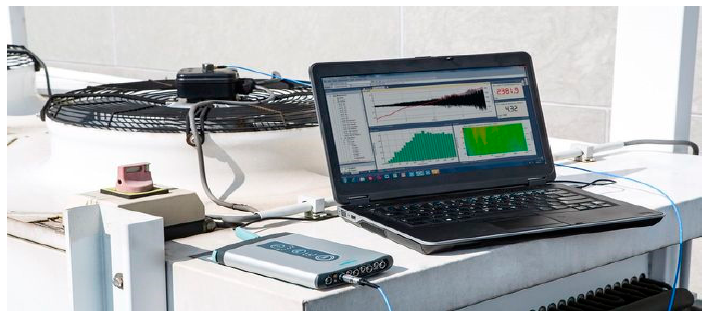
Figure 6. SIEMENS LMS Test.Xpress measuring